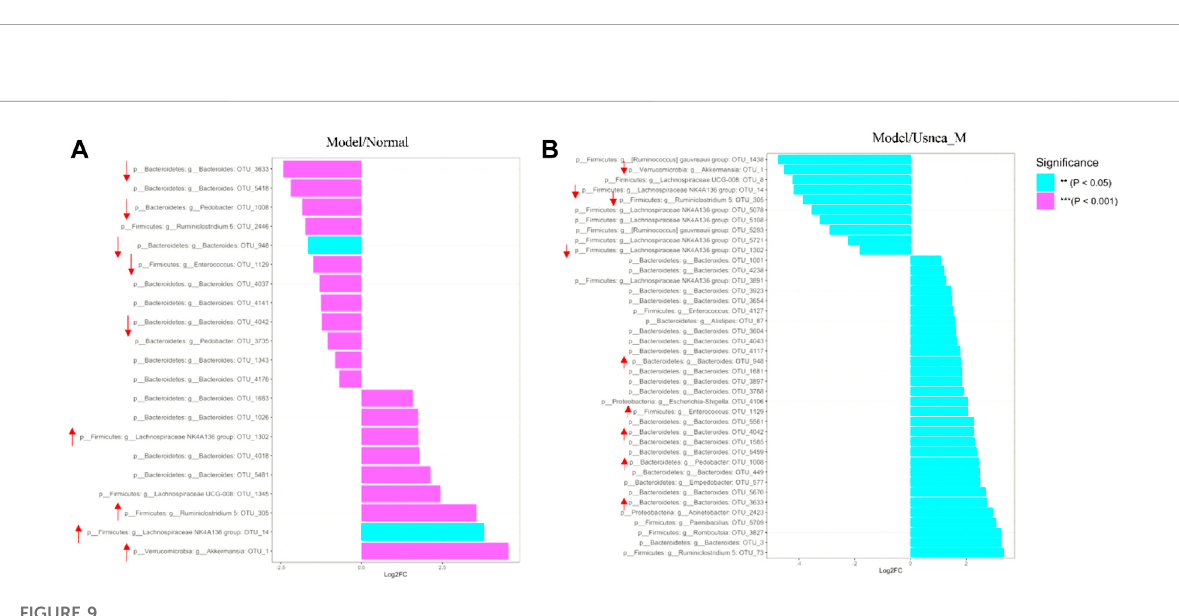
FIGURE 9 Differential analysis of the intestinal fl ora. (A) Differential intestinal fl ora at the phylum and genus levels between normal and model rats. (B) Differential intestinal fl oraatthephylumandgenus levelsbetweenratsinthemodeland Usnea _Mgroups.Positivevaluesoflog 2 FC(foldchange)on the horizontal axis represent upregulated species, whereas negative values represent downregulated species. Up- and downregulation pertain to ratsinthemodelgroup. The vertical axisindicates thespecies taxonomic attributes, withthree columns for thephylum,genus,and